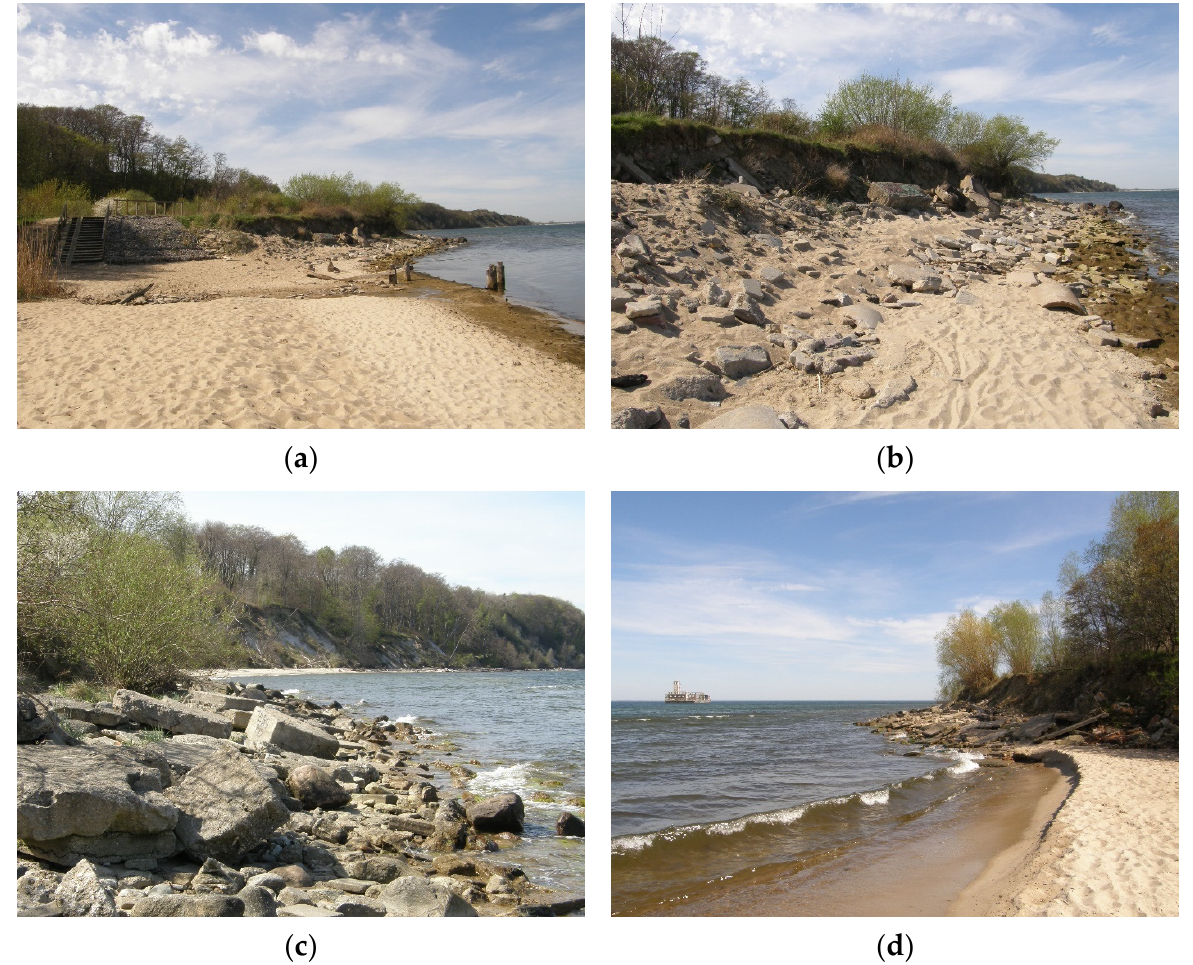
Figure 5. Revetment at KM 93.6–93.9; ( a ) seashore directly before the revetment at KM 93.55; ( b ) southern end of the revetment at KM 93.6; ( c ) middle section of the revetment at KM 93.8; ( d ) northern end of the revetment at KM 93.9; sea state: 501 cm; 13.00 UTC, 10 May 2021 (photo by R. Ostrowski).